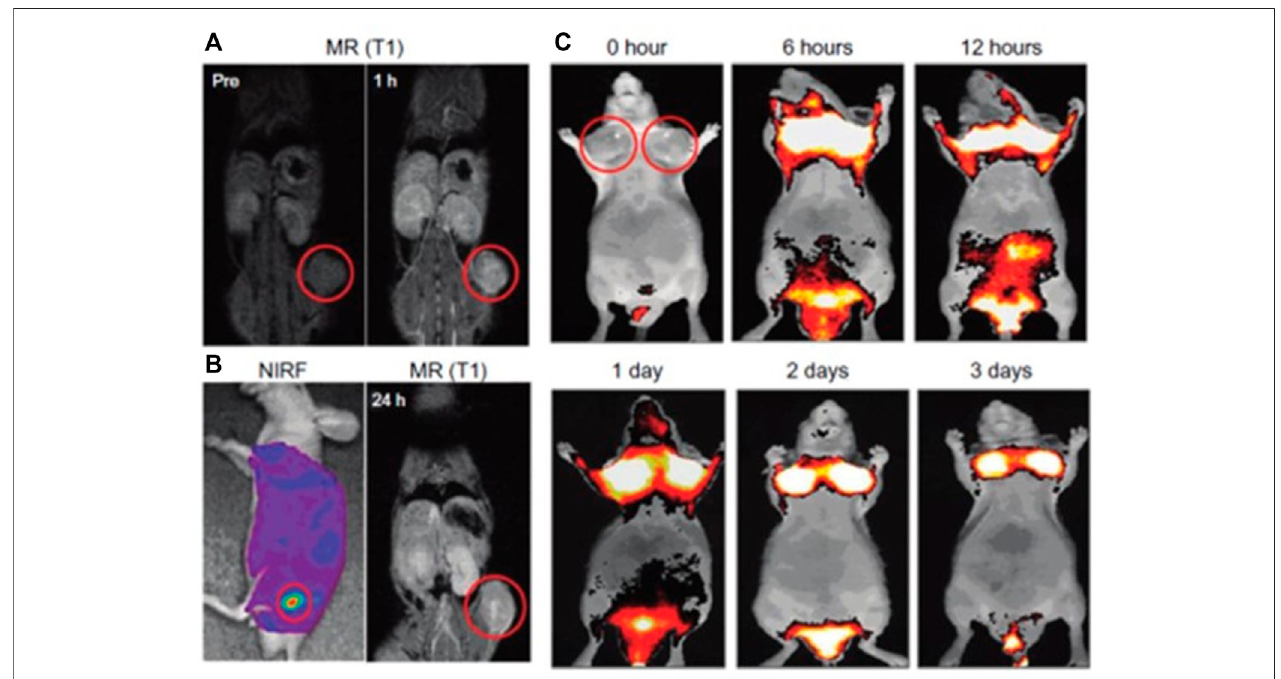
FIGURE 1 | (A – C) In vivo magnetic resonance (MR) – near-infrared fl uorescent (NIRF) dual-modality imaging of SCC7-bearing mice. Cy5.5-chitosan nanoparticle- Gd(III) nanoparticles were injected intothe SCC7-bearing mice, and the mice were visualized by using MR and NIRF imaging. Red circles indicate tumor sites. (A) In vivo MR imaging showed T1-positive contrast effects 1 h after injection at the tumor sites. (B) Both NIRF and T1-weighted MR images were simultaneously observed after 1 day post injection of Cy5.5-CNP-Gd(III). In vivo NIRF imaging showed brighter NIRF intensity at the tumor site. In vivo MR imaging 24 h after injection showed bright contrast effects at the tumor site. (C) In vivo NIRF imaging showed the accumulated Cy5.5-CNP-Gd(III) nanoparticles over time at the tumor sites. Reprinted (adapted) with permission from [44], Nam et al., 2010). Copyright (2021) American Chemical Society.